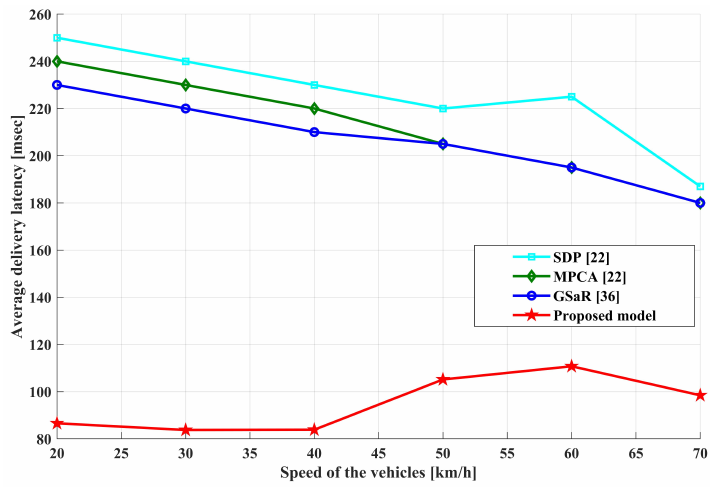
Figure 12. Average delivery latency (DL) vs. speed of the